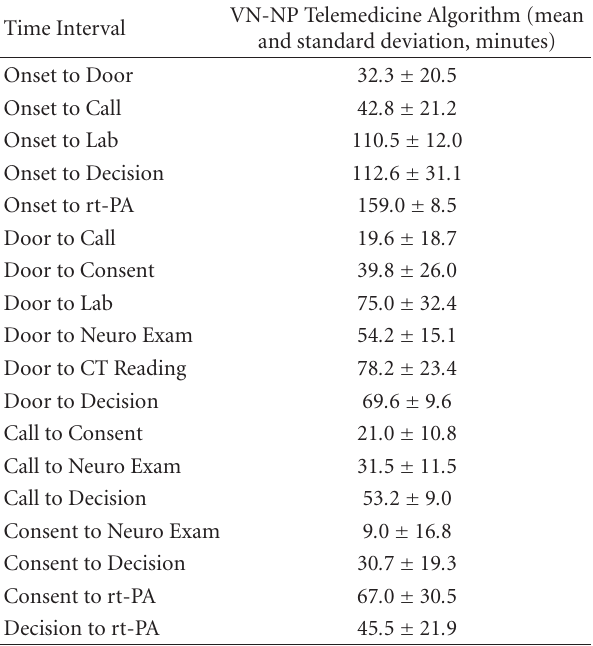
Table 3: Consultation time